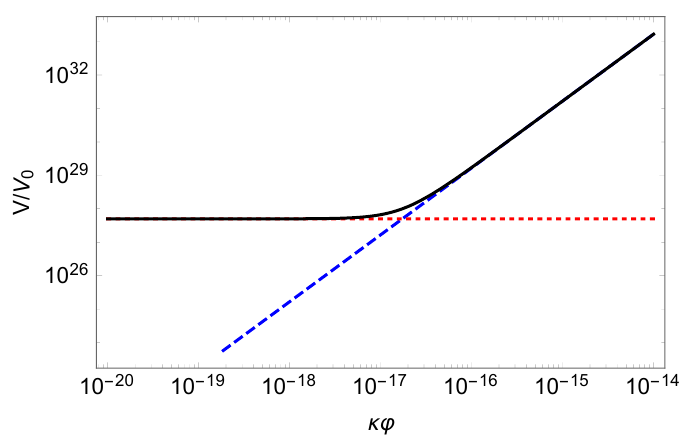
Figure 4 . The approximated e(cid:11)ective potential in the BBN epoch (black solid line), which is the sum of the original potential (blue dashed line) and the matter contribution (red dotted line), with (cid:0) T (cid:22) (BBN) =(cid:26) (cid:3) (cid:24) 10 29 (cid:22)